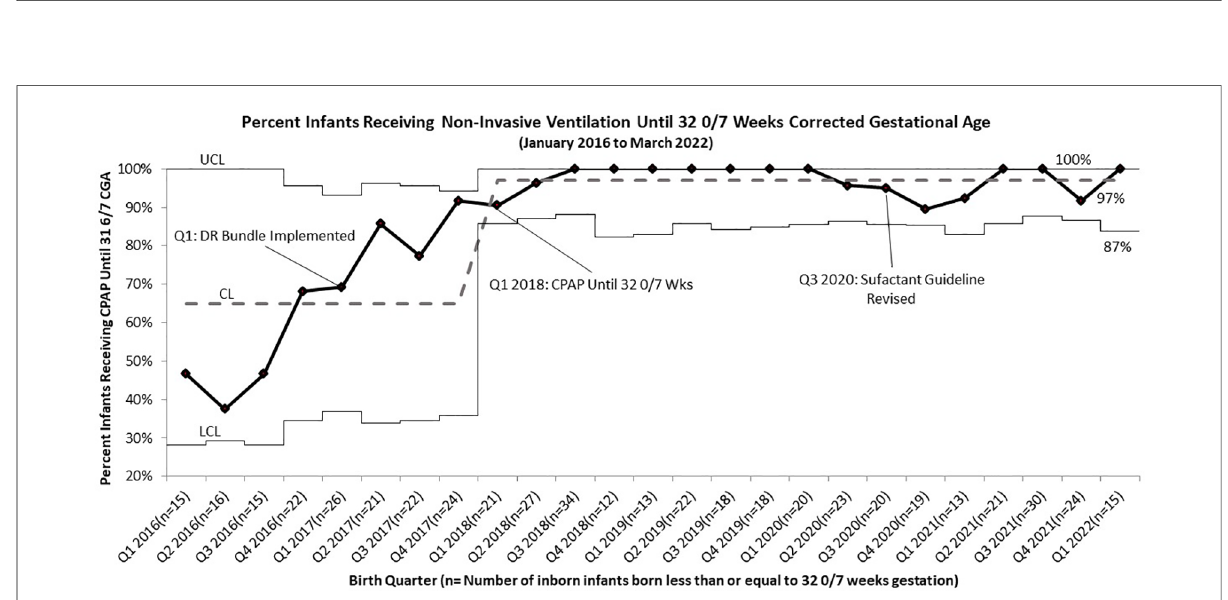
FIGURE 3 p Chart of Compliance with BPD Bundle Guidelines for Infants Born Less than or Equal to 32 0/7 Weeks Gestation to Receive Continuous Positive Airway Pressure Until 32 0/7 Weeks Corrected Gestational Age (Including those that were removed the evening of 31 6/7